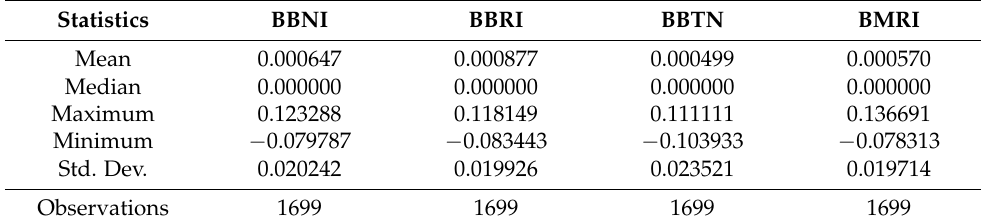
Table 1. Statistic descriptive.